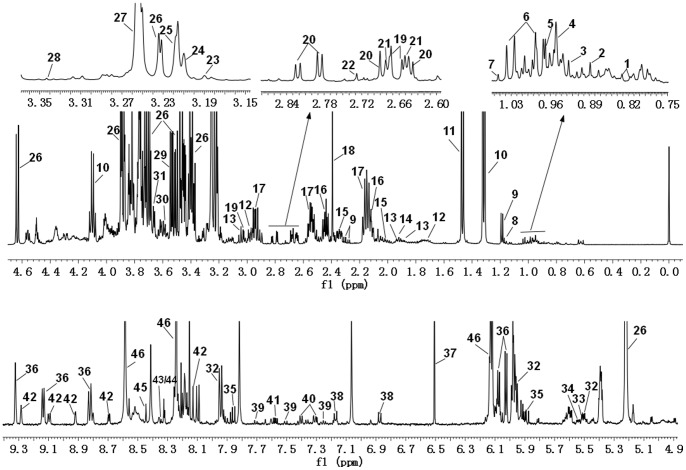
500 MHz 1H NMR spectra of aqueous liver extract.1, 2-Hydroxyisovalerate; 2, 2-Hydroxybutyrate; 3, Isoleucine; 4, Leucine; 5, 2-Aminobutyrate; 6, Valine; 7, Methylsuccinate; 8, Ethanol; 9, 3-Hydroxybutyrate; 10, Lactate; 11, Alanine; 12, Cadaverine; 13, Ornithine; 14, Acetate; 15, Glutamate; 16, Glutamine; 17, Glutathione; 18, Succinate; 19, Creatine; 20, Aspartate; 21, Malate; 22, Dimethylamine; 23, Choline; 24, O-Phosphocholine; 25, Carnitine; 26, Glucose; 27, Betaine; 28, Methanol; 29, Glycine; 30, Glycerol; 31, Ethylene glycol; 32, UDP-glucose; 33, UDP-glucuronate; 34, UDP-galactose; 35, Uridine; 36, NAD+; 37, Fumarate; 38, Tyrosine; 39, 3-Indoxylsulfate; 40, 3-Phenyllactate; 41, Nicotinurate; 42, NADP+; 43, Adenosine; 44, Inosine; 45, Formate; 46, ADP/AMP.